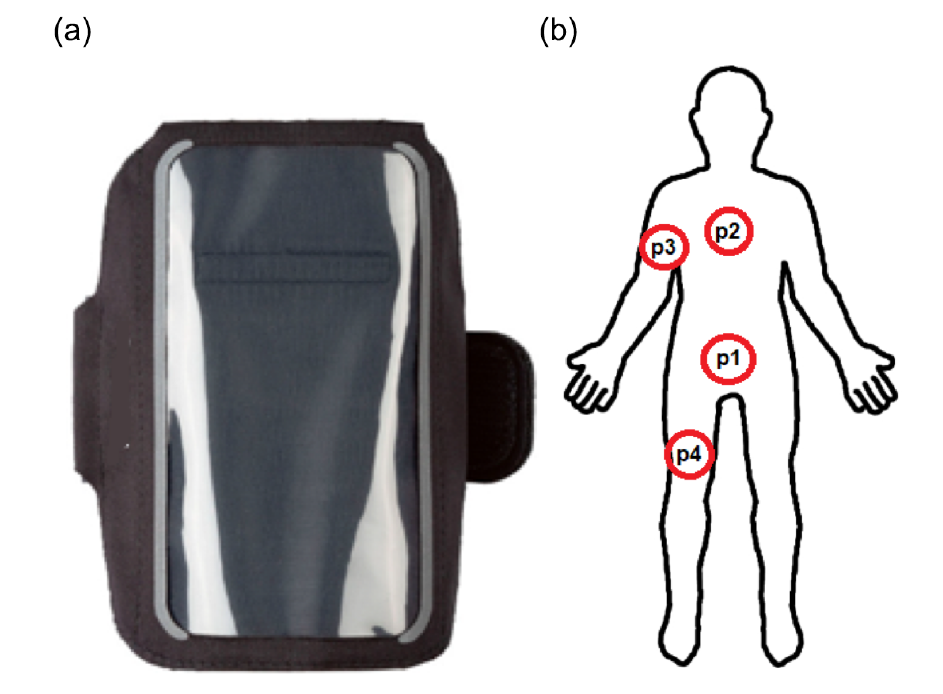
Figure 4. Elements of experimental testbed: ( a ) holding strap, ( b ) smartphone